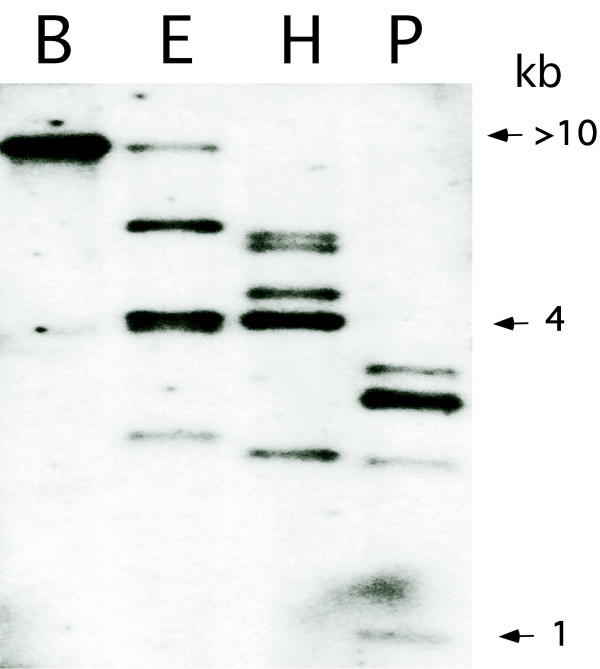
Southern blot of An. stephensi genomic DNA hybridized to the An. stephensi histone H1 probe. DNA was digested with BamHI (B), EcoRI (E), HindIII (H) and PvuI (P). Positions of size markers are shown at right.